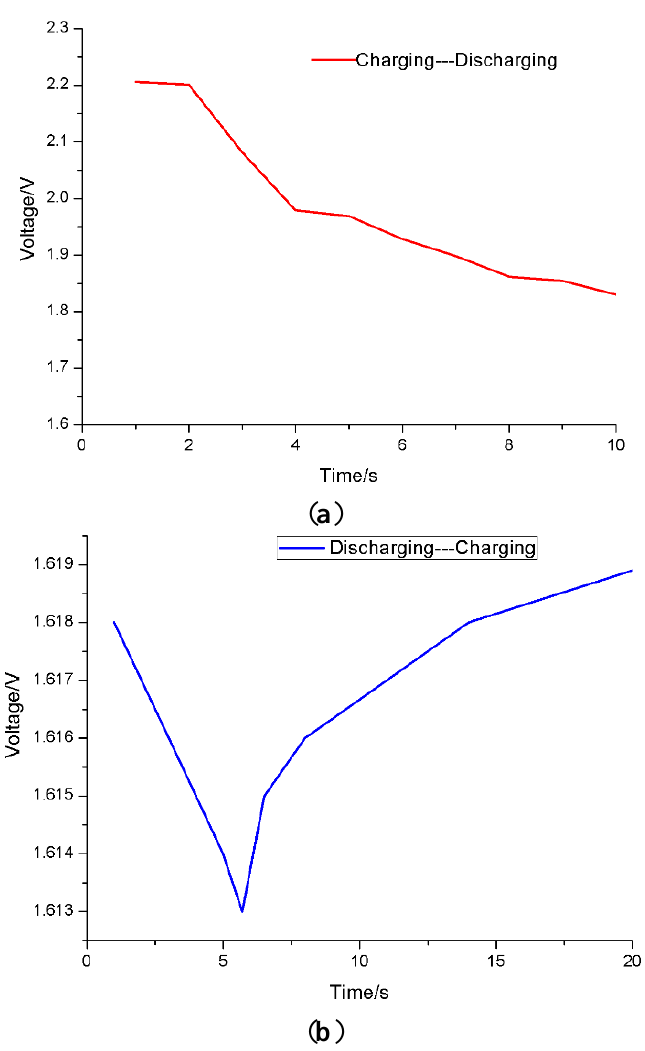
Figure 13. Turning points between charging and discharging and vice versa. ( a ) Turning points between charging and discharging; ( b ) Turning points between discharging and